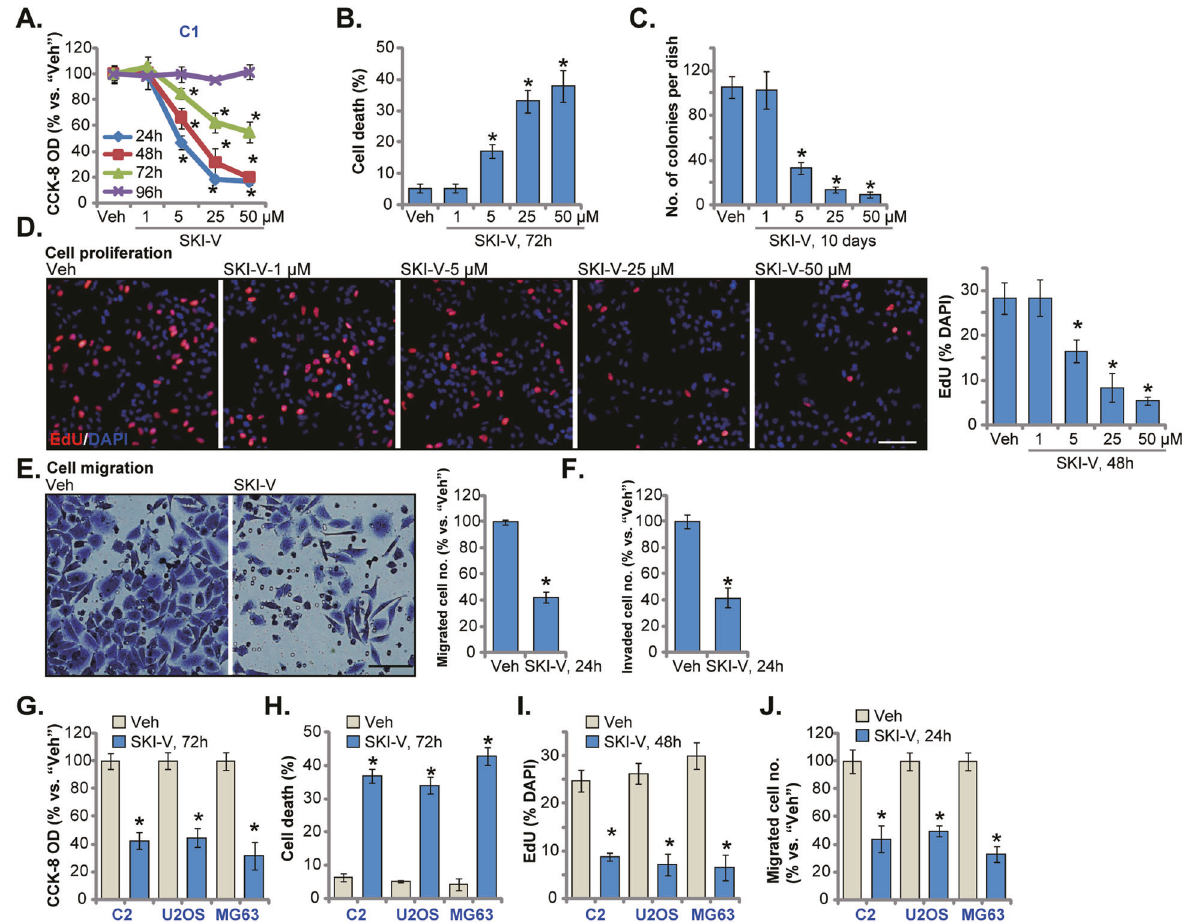
Fig. 1 SKI-V exerts signi fi cant anti-OS cell activity. The primary human OS cells ( “ C1 ” / “ C2 ” , A – J ) or the immortalized cell lines (U2OS and MG- 63, G – J ) were cultured in FBS-containing compete medium and treated with SKI-V (at 25 μ M or indicated concentrations) for applied time periods; Cellular functions, including cell viability ( A and G ), cell death (Trypan blue staining assays, B and H ), colony formation ( C ), cell proliferation (EdU assays, D and I ), as well as cell migration ( “ Transwell ” assays, E and J ) and invasion ( “ Matrigel Transwell ” assays, F ) were tested by the appropriate assays mentioned, with results quanti fi ed “ Veh ” stands for the vehicle control. Data were presented as mean ± standard deviation (SD, n = 5). * P < 0.05 vs. “ Veh ” group. Experiments were repeated fi ve times with similar results obtained. Scale bar = 100 μ m ( D , E